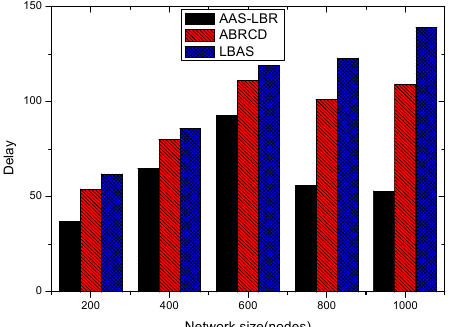
Figure 44. The impact of network size with fixed value of | T | = 30 on the broadcast delay.